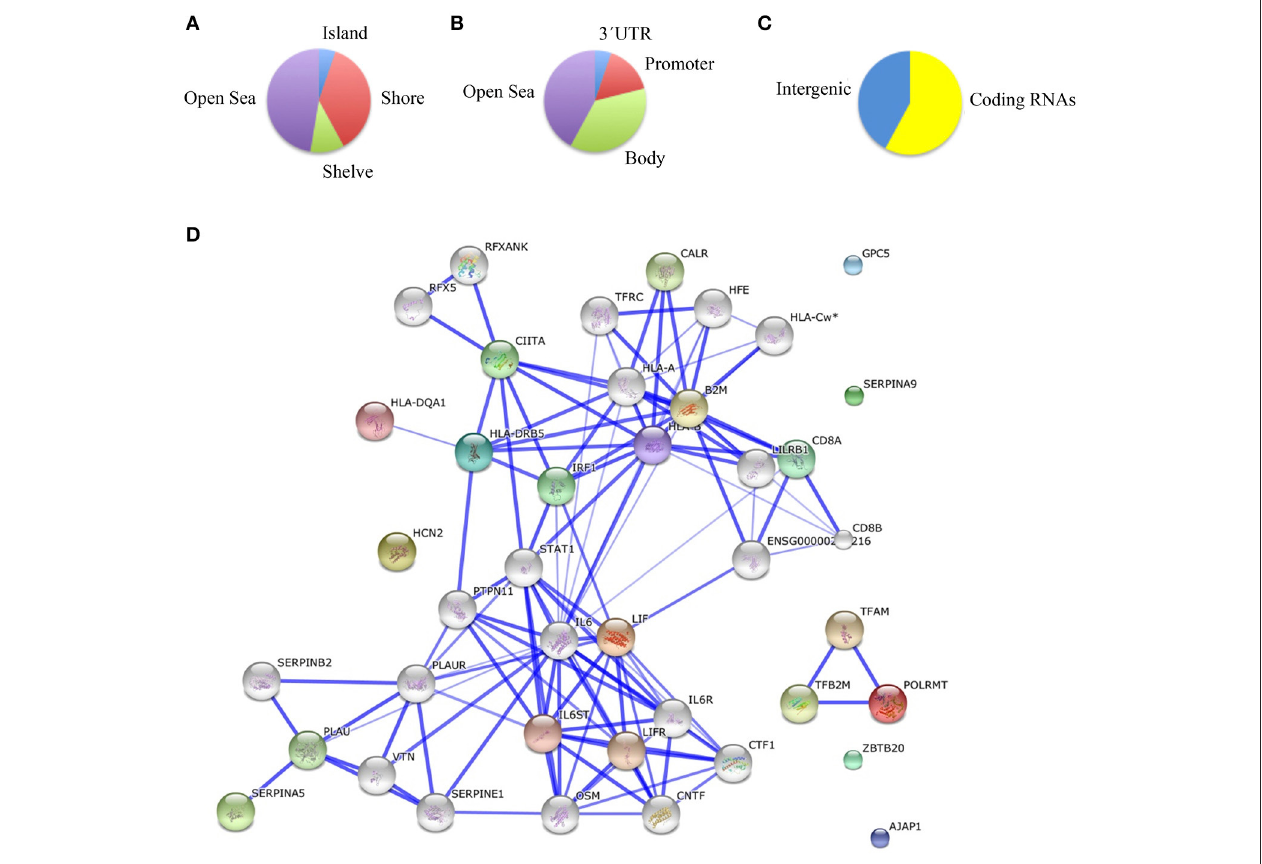
FIGURE 3 | (A) Functional genomic distribution, (B) CpG content and neighborhood context, and (C) associated RNA transcripts of the 18 differentially methylated CpGs between schizophrenic and healthy samples in the hippocampus; (D) Network analysis (STRING V9.05).